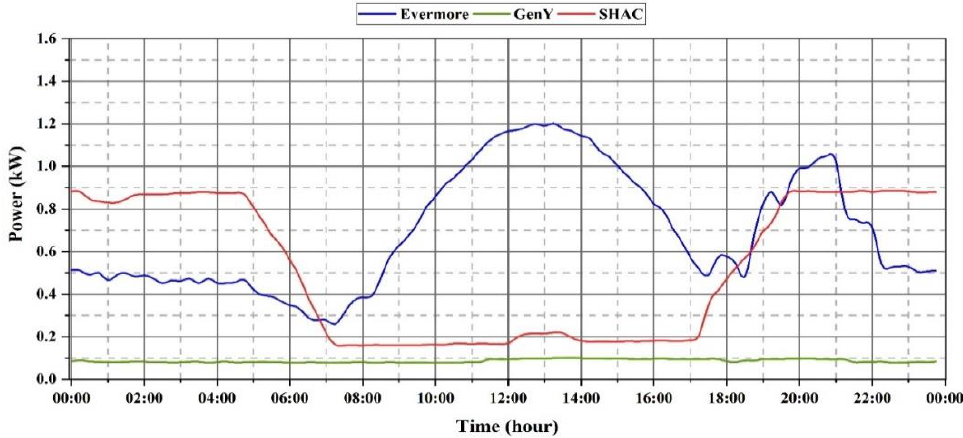
Figure 3. CP diurnal load profile averaged over the period of available data for each site.